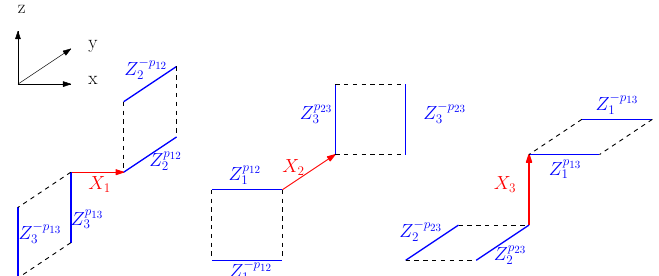
Figure 2: The Hamiltonian model (3.19) for the subsystem SPT phase, where there are x k -type (cid:90) degrees of freedom on the edges in the x k direction, acted upon by N Pauli matrices X , Y , Z . One subsystem symmetry is a product of X operators over k k k edges in the x direction that intersect a yz plane on the dual lattice. Subsystem symmetries for xz and x y planes are